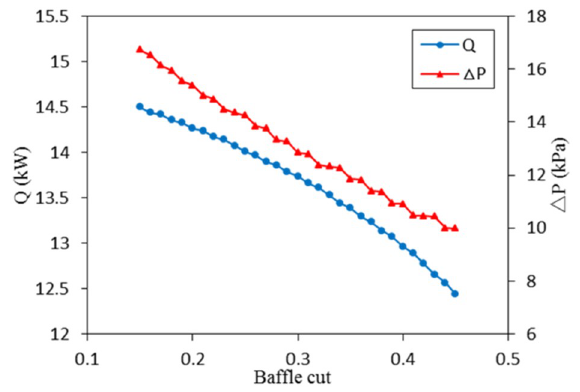
Figure 13. Heat transfer capacity and shell-side pressure drop separately versus baffle cut.